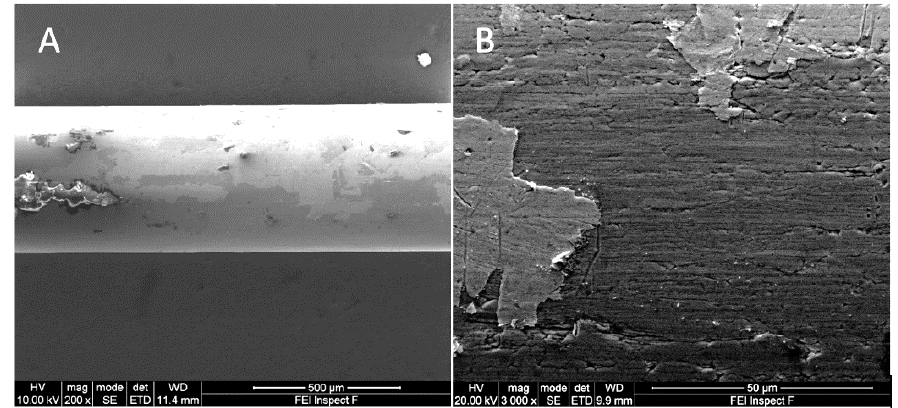
Figure 2. SEM (Scanning Electron Microscope) images of UHV coated stainless steel needle shaft showing partial delamination of silver layer after washing step. ( A ) Light zones indicate Ag silver layer; dark zones indicate stainless steel. ( B ) Higher magnification; layer thickness is 150 nm.